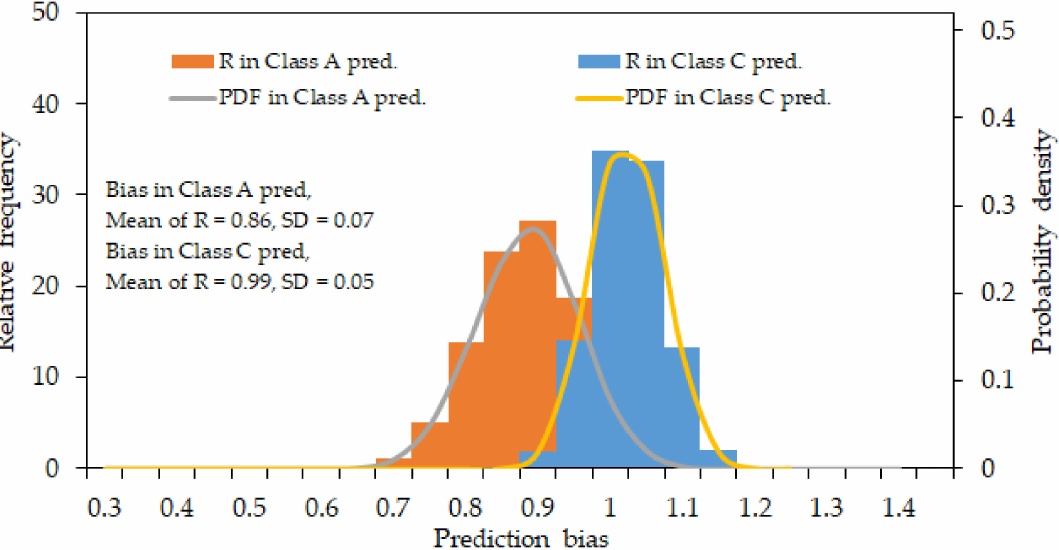
Figure 9. Distribution of settlement prediction bias for average values of R from Class A and Class C—Ballina